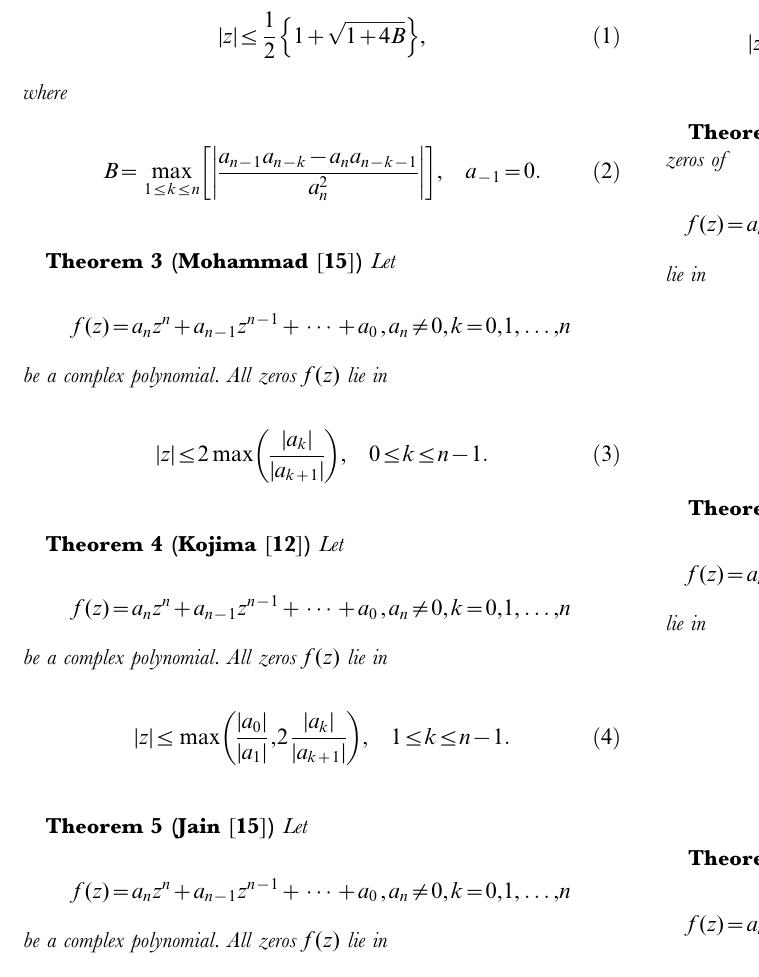
Table 1. Mean bounds values for polynomials P i [ C 1